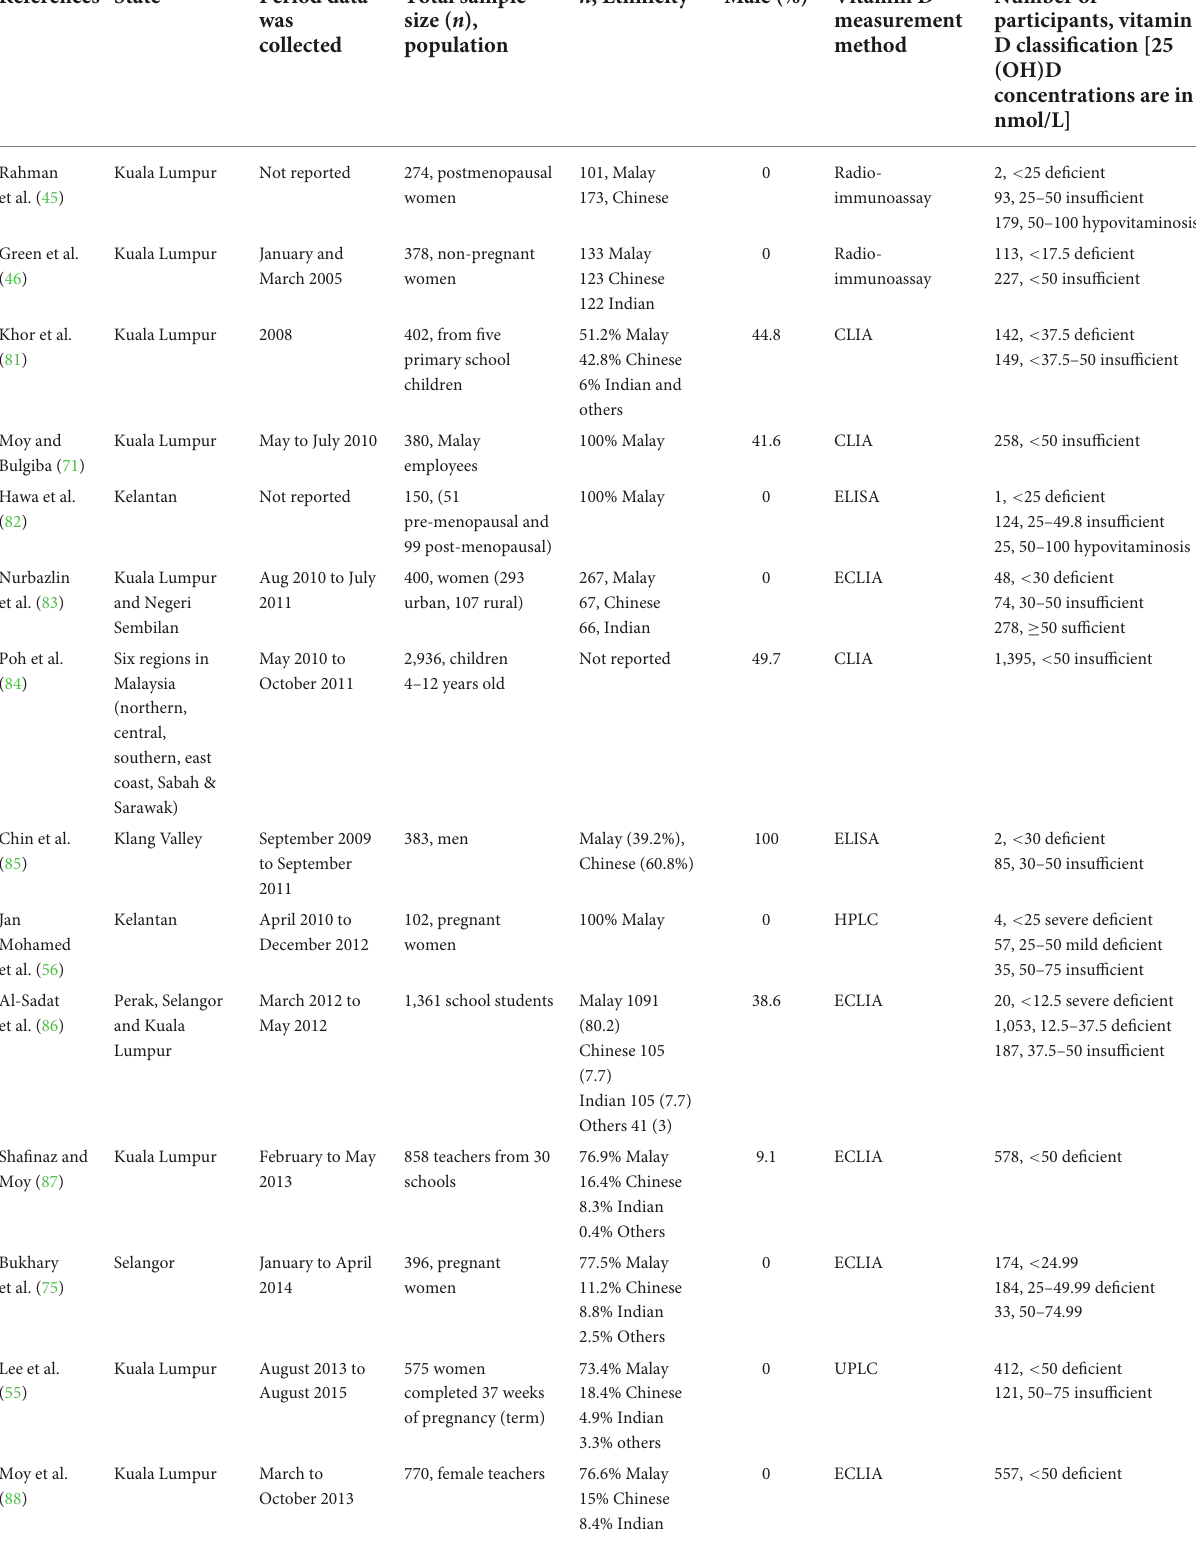
TABLE 1 Characteristics of studies included in the systematic